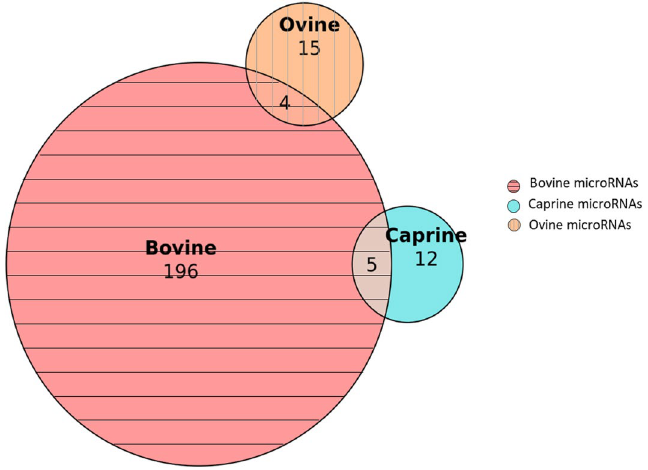
Figure 1. Number of microRNAs presenting at least one variant in a precursor in bovine, caprine and ovine species. Five microRNAs present variants both in bovine and caprine species. Four microRNAs present variants both in bovine and ovine